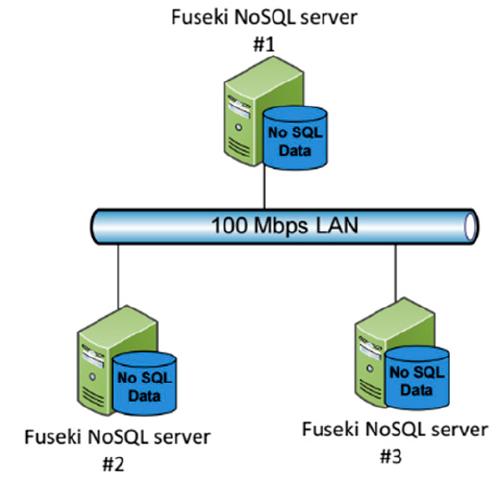
Figure 1. Fuseki NoSQL server installation.